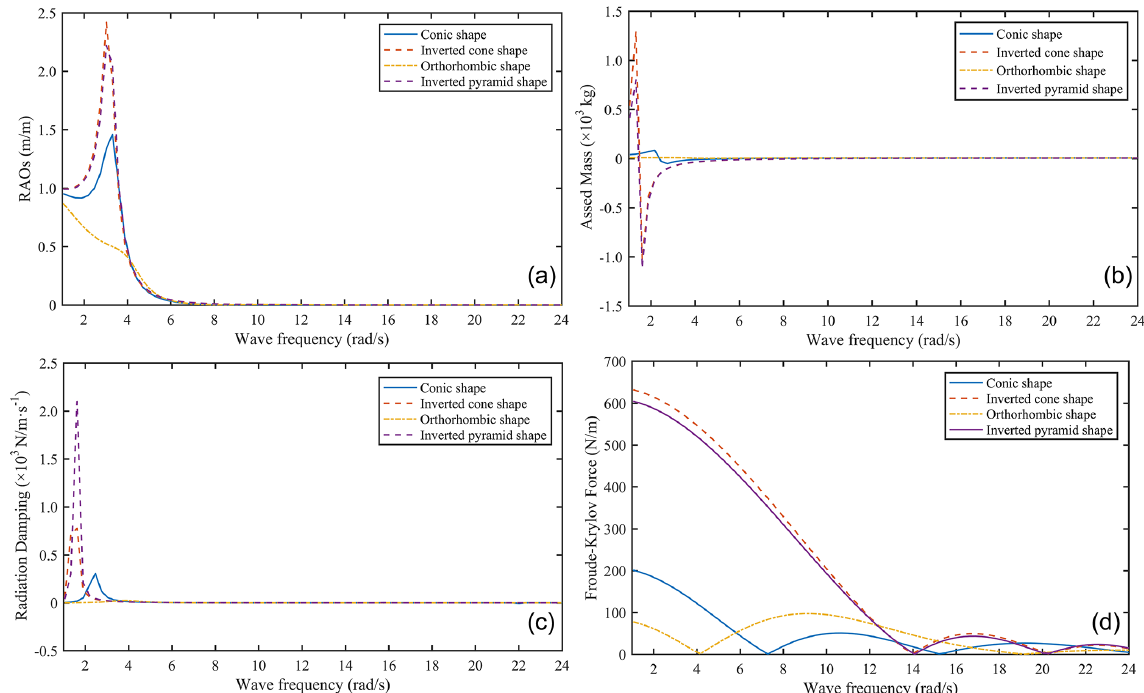
Figure 5. Energy efficiency comparison of cone and pyramid floating bodies. (a) RAOs. (b) Radiation damping. (c) Added mass. (d) Froude– Krylov